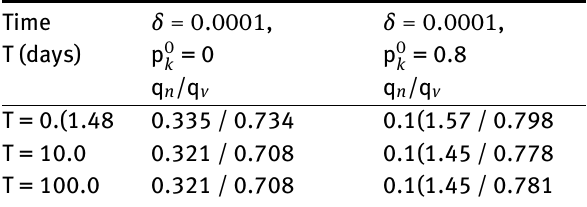
Table 1: The results of calculations of the flowrate of untreated wells